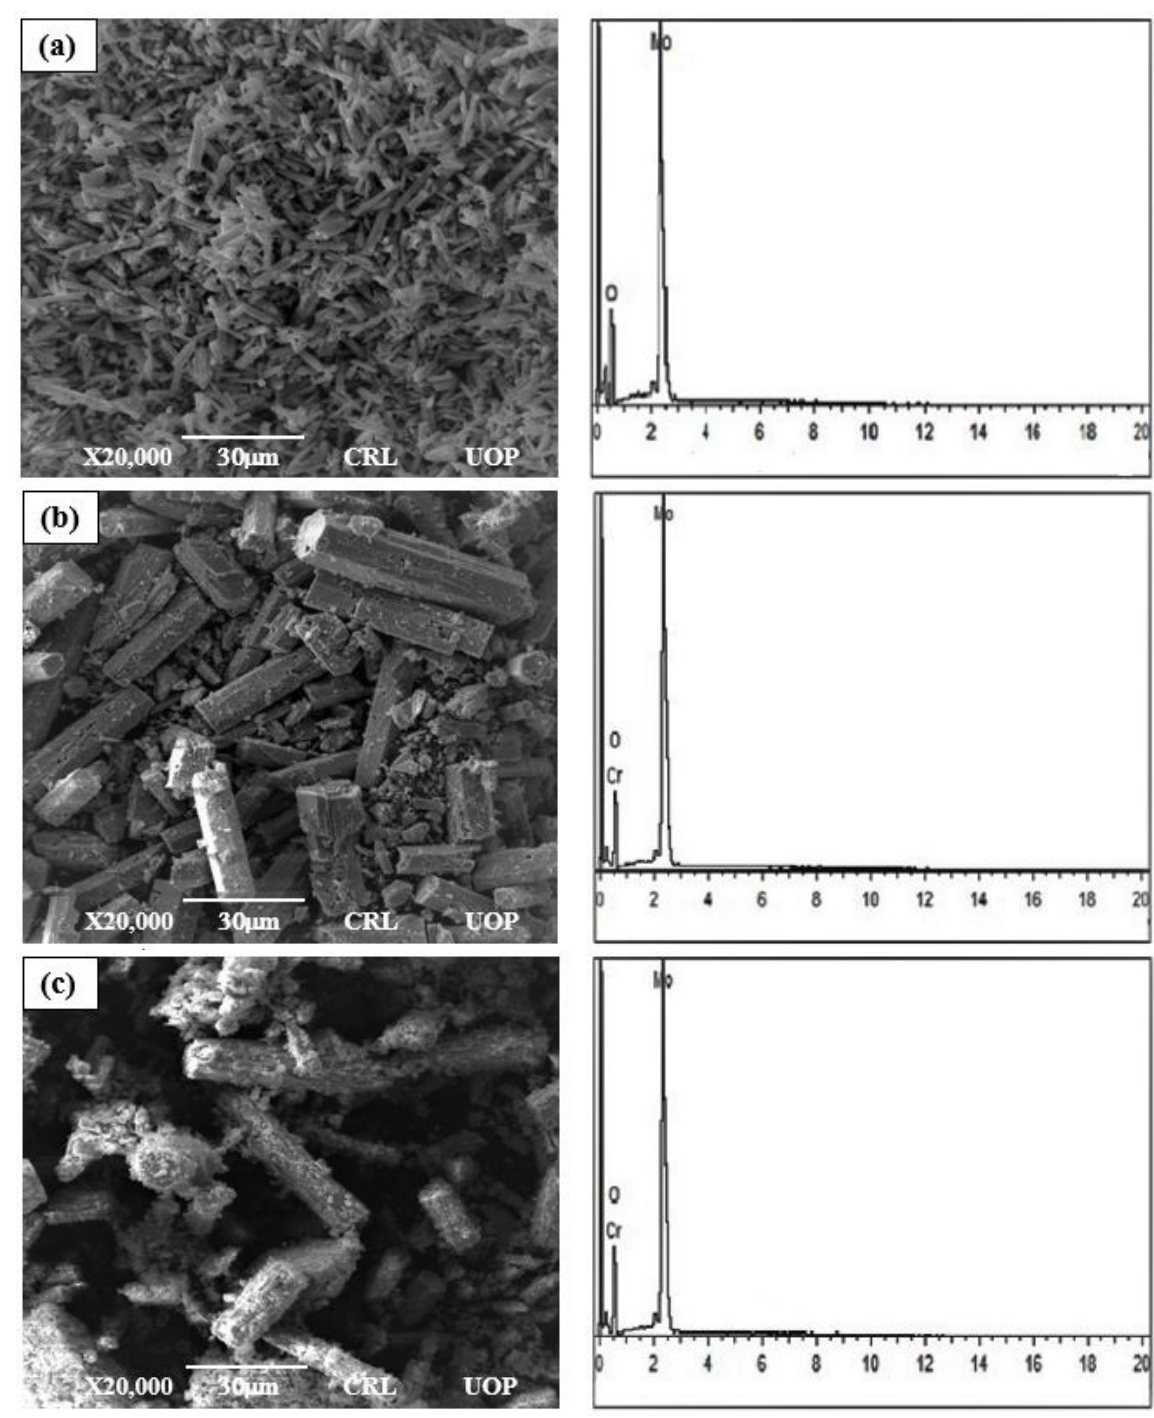
Figure 4. The SEM and EDX micrographs of the ( a ) un-doped, ( b ) 3%, ( c ) 6% Cr-doped MoO 3.